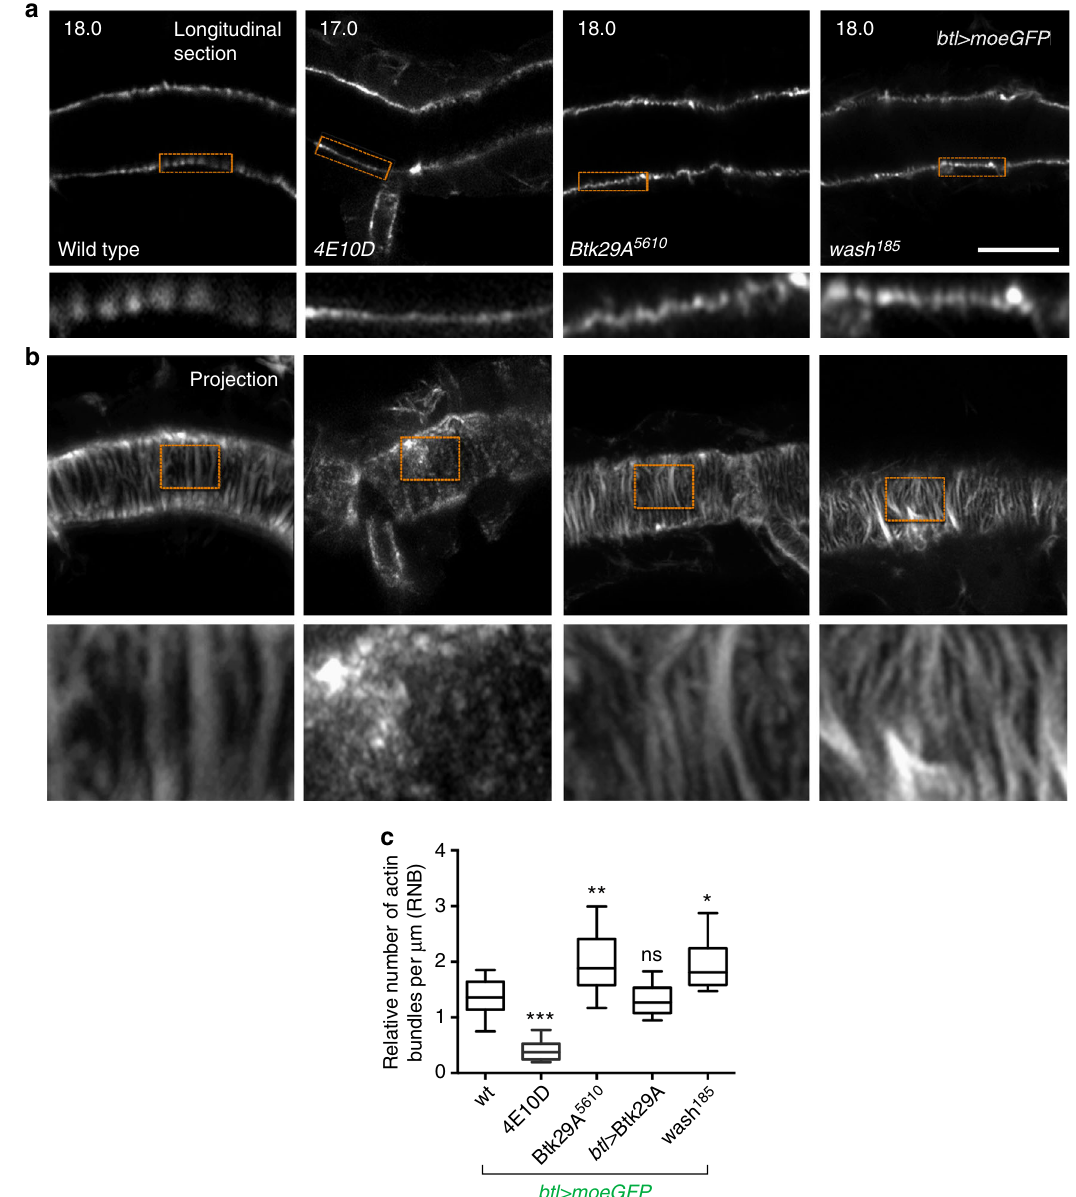
Fig. 5 A new role of protein tyrosine phosphatases (PTPs) in actin cytoskeleton regulation. a , b Airyscan confocal images of the dorsal trunk of wild-type, Ptp4EPtp10D, Btk29A 5610 and wash 185 embryos expressing the actin reporter btl>moeGFP (grey). Images were acquired during luminal endocytosis, 18 h after egg laying (AEL) (for wild-type, Btk29A 5610 and wash 185 ) and 17 h AEL (for Ptp4EPtp10D) . Longitudinal sections ( a ) and Z -stack projections ( b ) are shown. Lower rows in a and b depict zoomed view of areas indicated by the rectangular frames. Scale bars, 10 μ m. c Plots showing the relative number of actin bundles (>2 μ m long) per μ m (RNB) in wild type ( n = 10), Ptp4EPtp10D ( n = 8), Btk29A 5610 ( n = 14), btl > Btk29A (type-2) ( n = 11) and wash 185 ( n = 14) embryos expressing btl>moeGFP . The boxplot shows the median (horizontal line) and the data range from 25th to 75th percentile. The bars denote maxima and minima values. * P < 0.01, ** P < 0.001, *** P < 0.0001 indicates statistical signi fi cance in comparison to wild-type (unpaired two tailed t